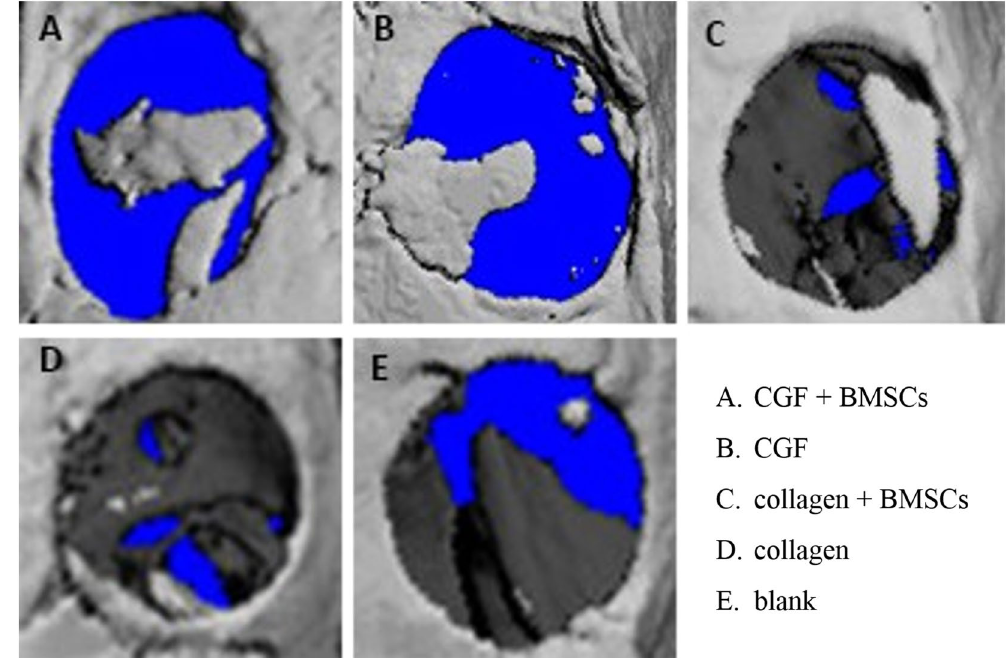
Figure 5. 3D images of the newly formed bone 6 weeks after operation were reconstructed by micro-CT in five different experimental groups: ( A ) CGF + BMSCs; ( B ) CGF; ( C ) collagen + BMSCs; ( D ) collagen; ( E ) blank.